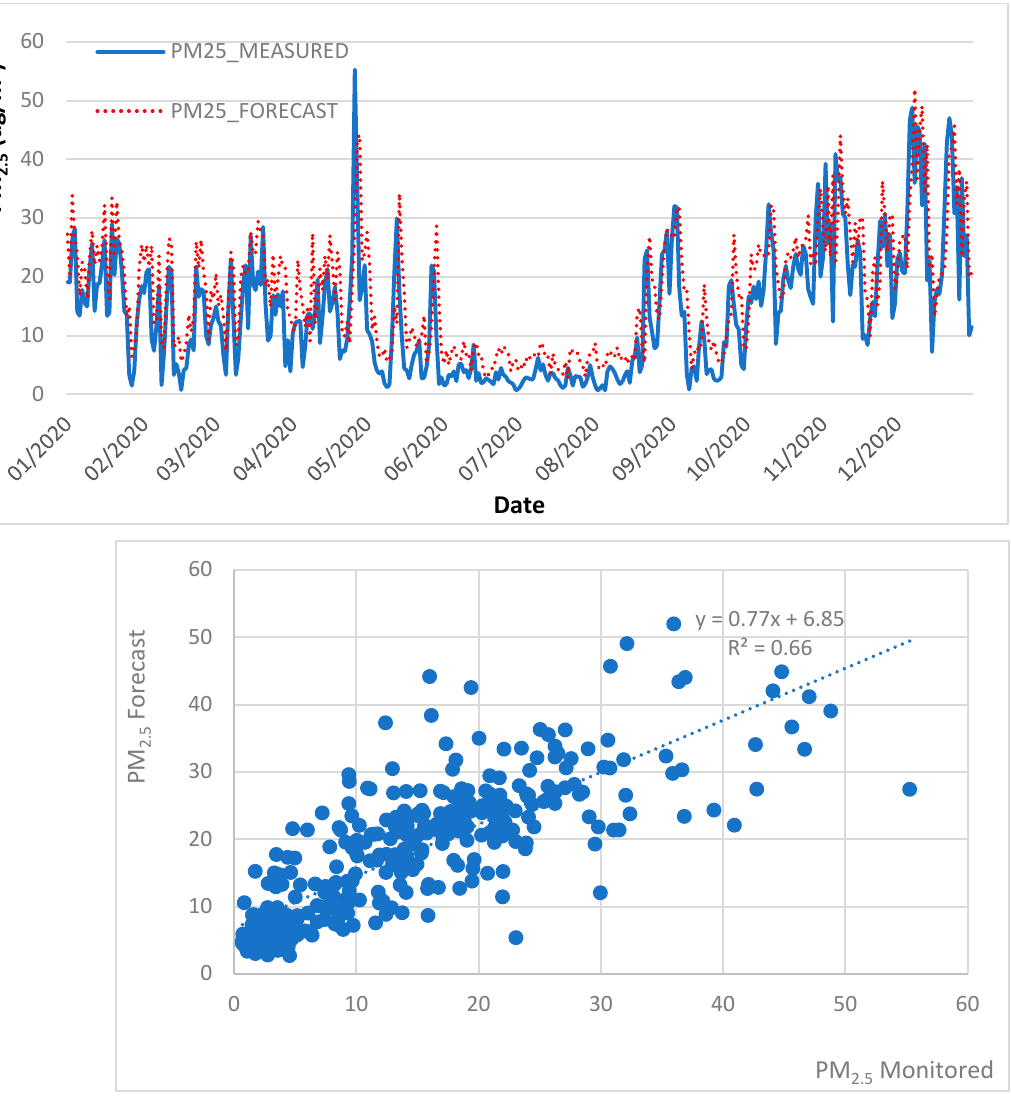
Figure 5. Observed and predicted PM 2.5 concentrations using GB in 2020 .